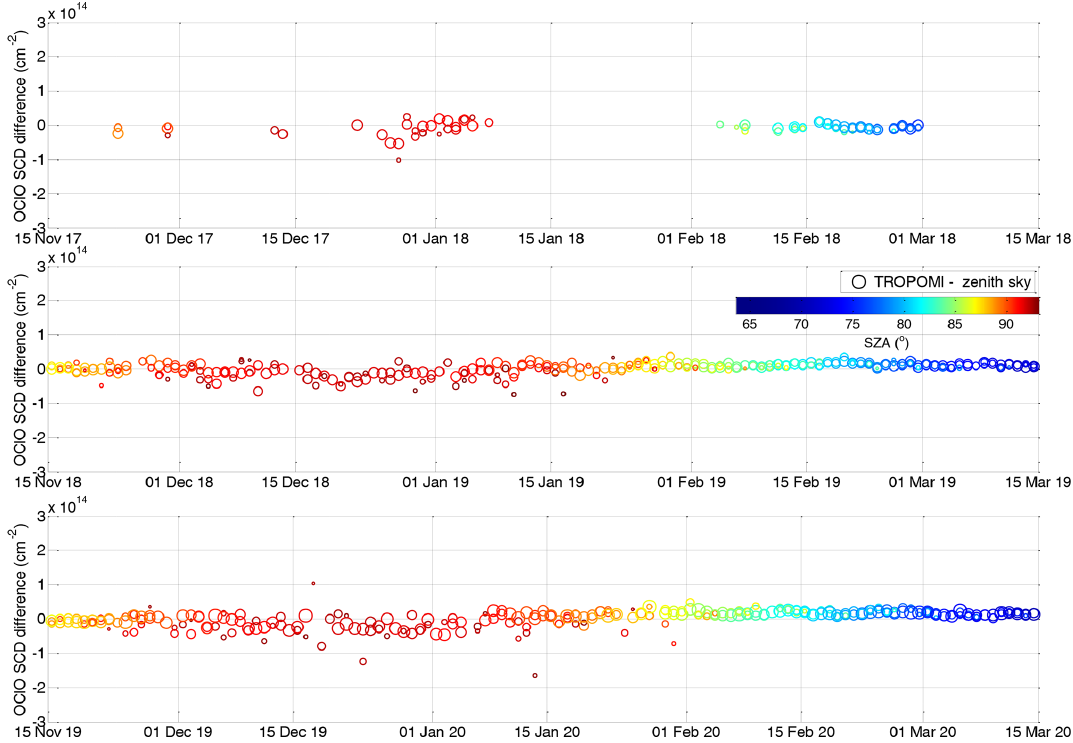
Figure 5. Difference between the collocated TROPOMI OClO SCD measurements and the ground-based measurements in Kiruna for three different winters. Colour coding and radius of the circles is the same as in Fig. 4.